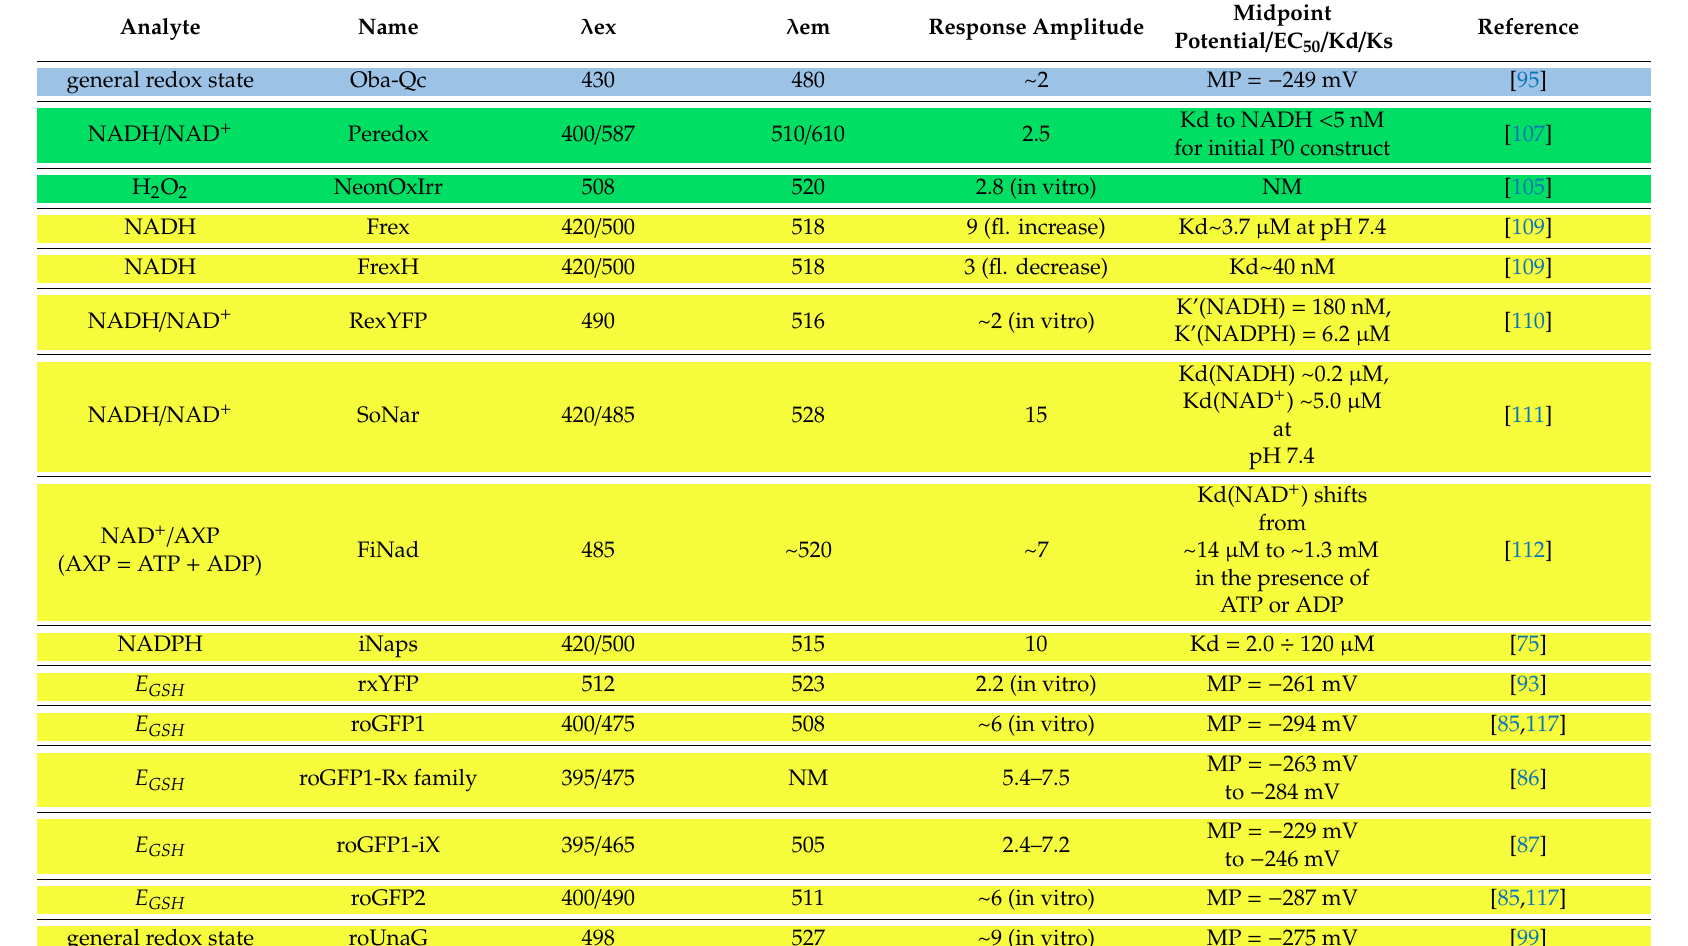
Table 1. Some important characteristics of redox-sensitive GEFIs applied in